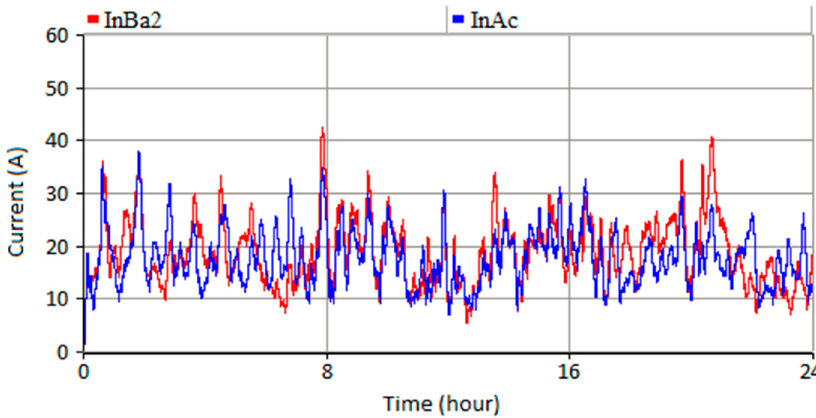
Figure 20. NCC under communication delay for case Ba-Accuracy against case Ac.